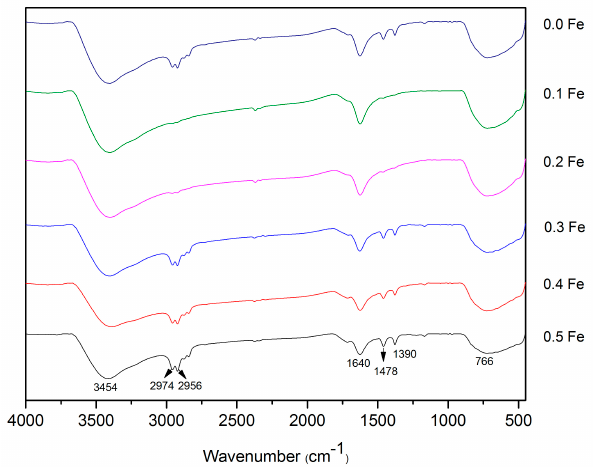
Figure 1. Fourier transform infrared (FTIR) spectra of the photocatalyst at different amounts of Fe.